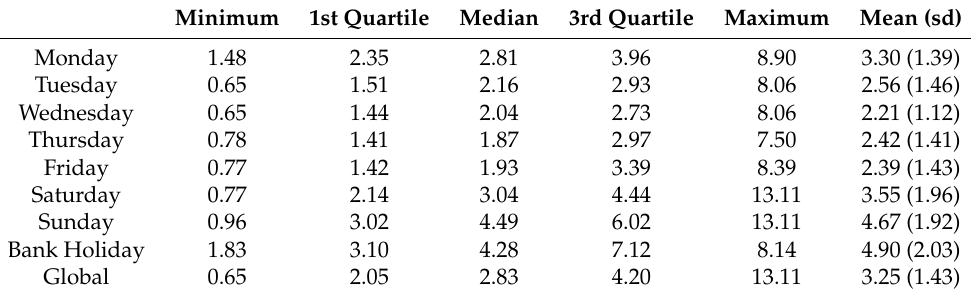
Table 13. Daily MAPE (in%) for model (10).